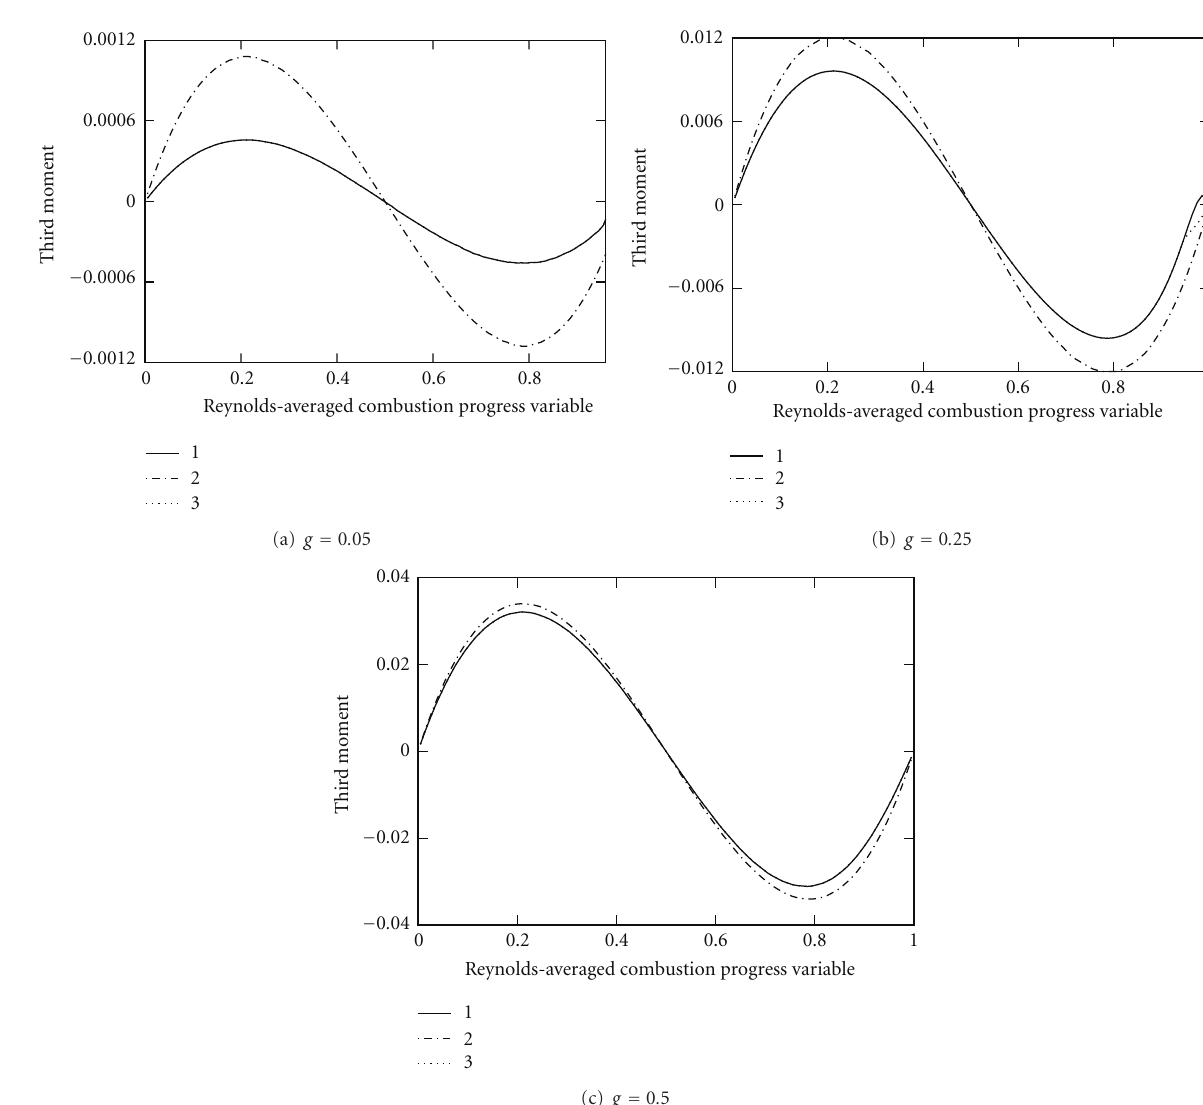
Figure 4: Dependencies of ξ (cid:3) 3 on ξ , calculated for the beta-function PDF (curves 1), the R-2 δ -PDF (curves 2), and the 2 δ -PDF (curves 3). (a) g = 0 . 05, (b) g = 0 . 25, (c) g = 0 .